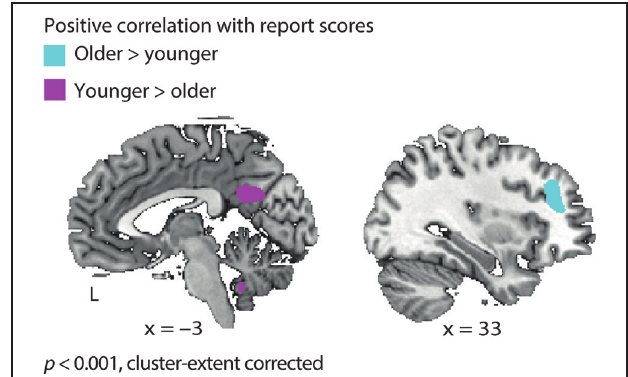
FIGURE 5 | Age group × comprehension interaction . In older adults the hemodynamic response in middle frontal gyrus covaried with comprehension of degraded speech on a trial-by-trial basis (i.e., report scores); young adults did not exhibit such a correlation. Incontrast, young adults showed additional correlations with report scores in the posterior cingulate cortex, left fusiform gyrus and right cerebellum (see Table 2 ).